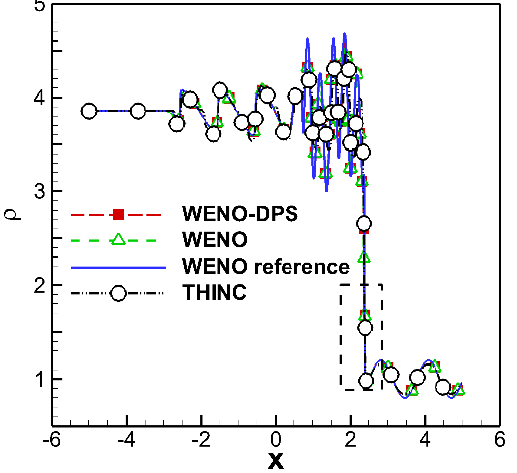
Figure 13. Density plot of Mach 3 test case Figure 14. Zoomed view of the density